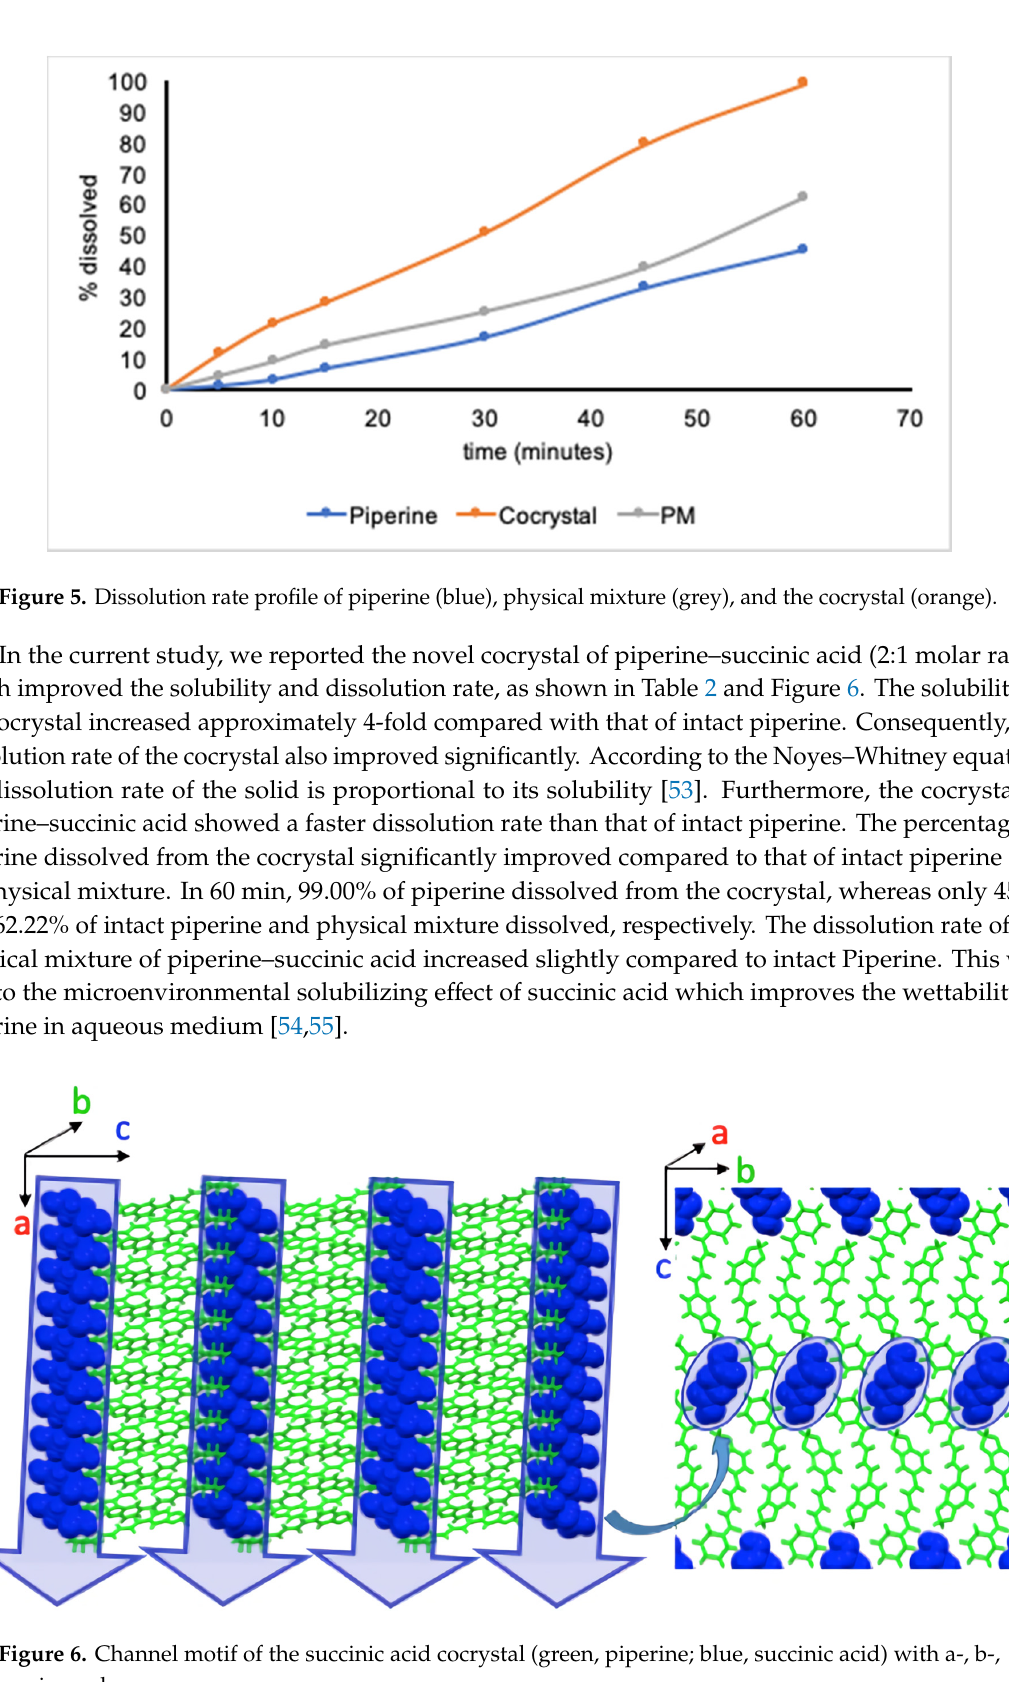
Figure 4. H-bond between piperine and succinic acid and the three-molecule unit of piperine and succinic acid.